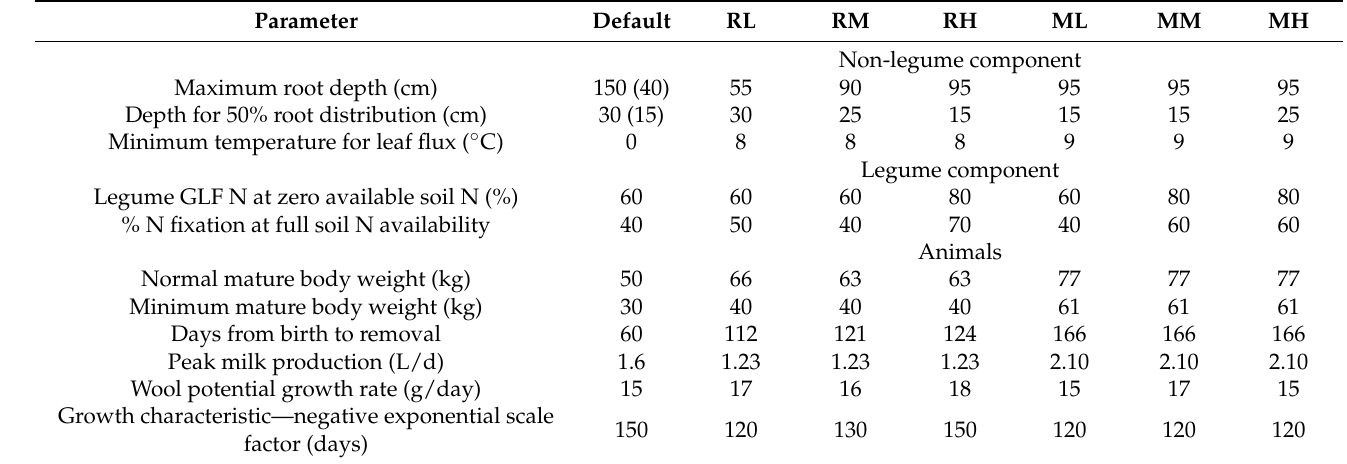
Table 3. Changes to the model defaults for the grass (non-legume) and legume component (sub- clover) defaults in the different grazing